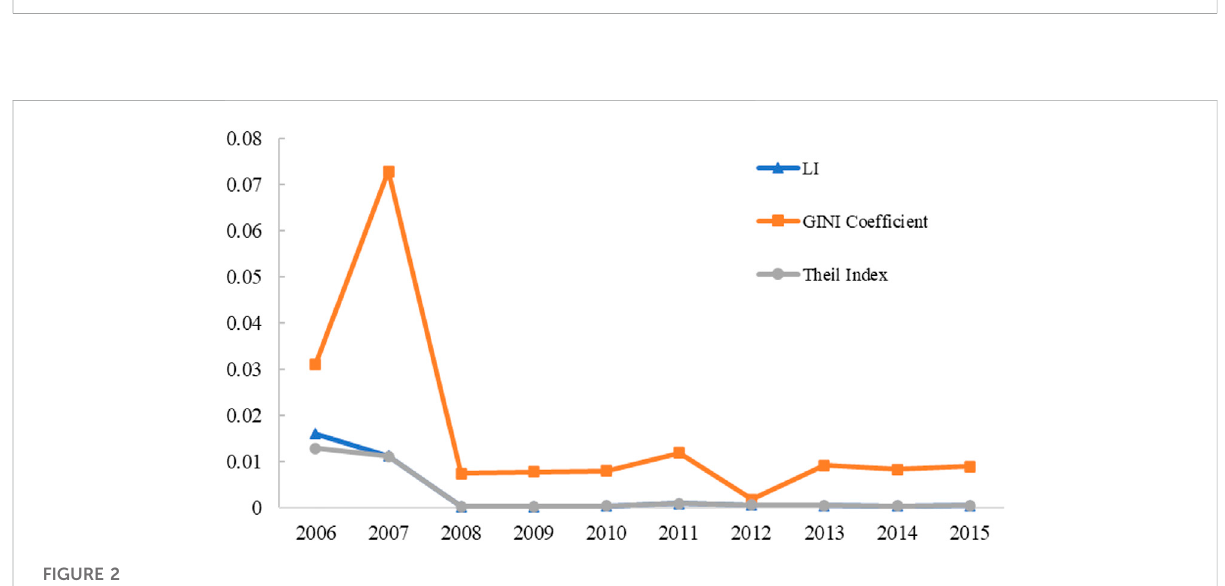
FIGURE 1 Global biodiversity footprint distribution of 188 countries/regions. Note: The value is calculated based on the average of the net import and export footprints of biodiversity in each country.